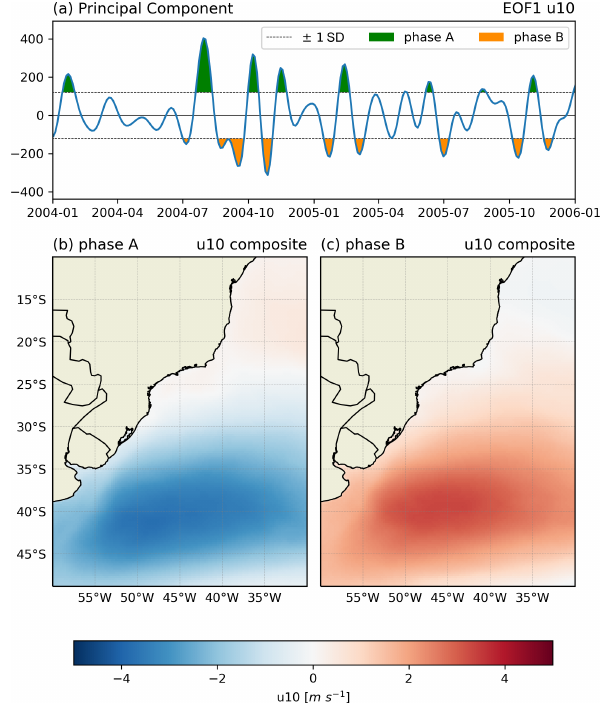
Figure 5. Time series of the EOF1 of (a) swh. Phase A (B) denotes periods when the time series presents values greater than (less than) + 1 ( − 1) standard deviation. The composites are the average value of swh anomaly during (b) phase A and (c) phase